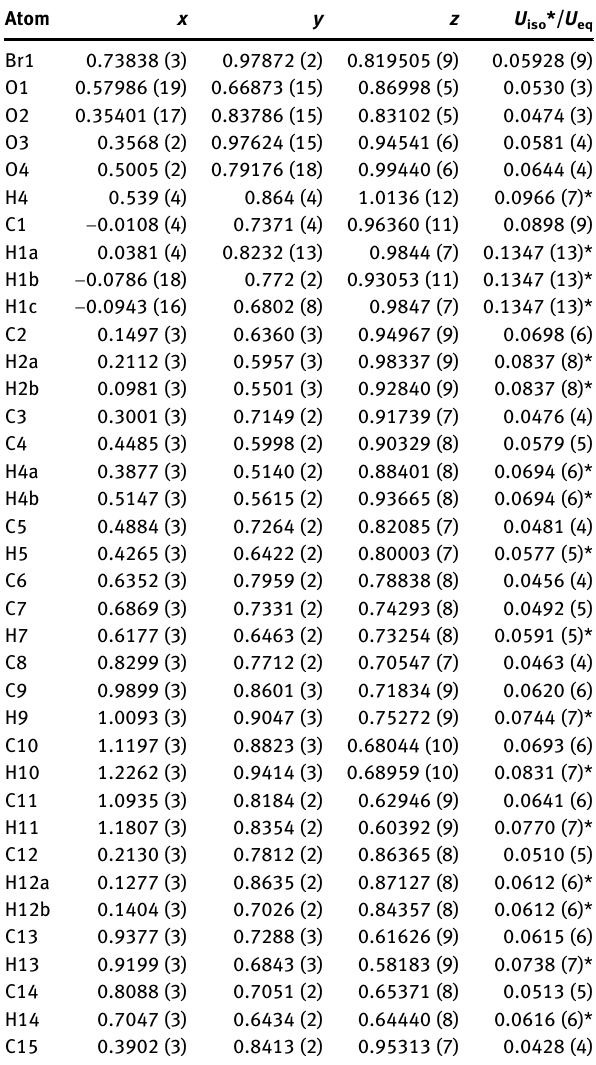
Table  : Fractional atomic coordinates and isotropic or equivalent isotropic displacement parameters (Å 